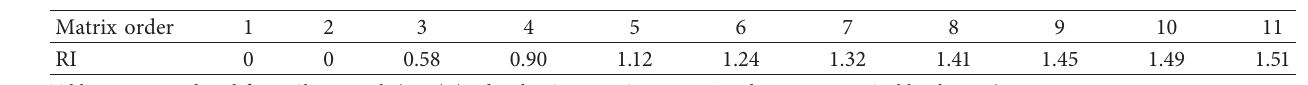
Table 19: Value of RI.